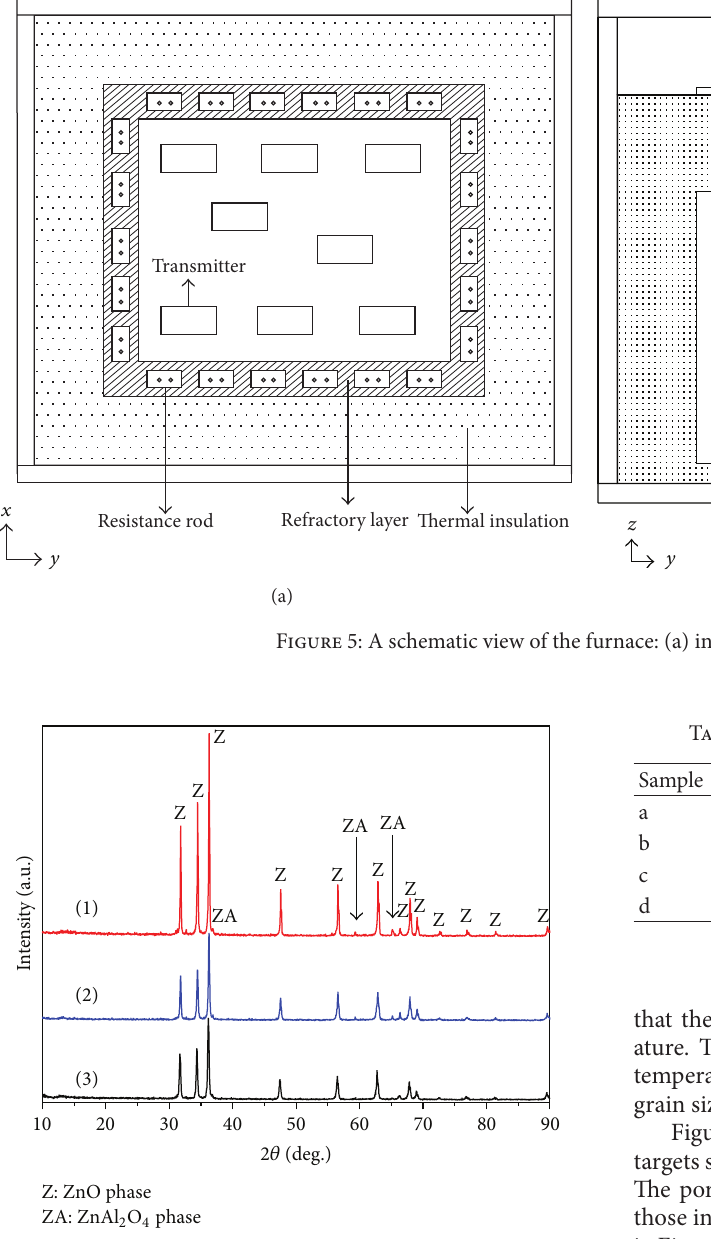
Figure 6: X-ray diffraction patterns for the AZO sample prepared through (1) conventional sintering, (2) (3) microwave sintering started at 1200 ∘ C, 1300 ∘ C.